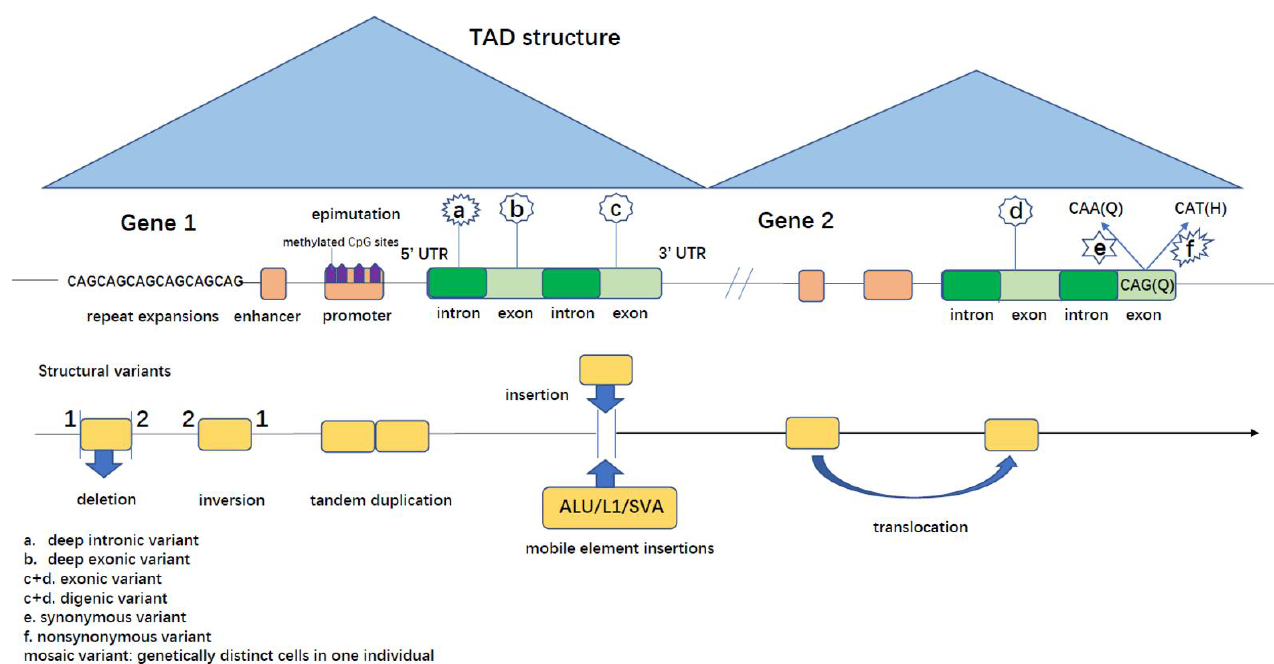
Figure 1. The schematic figure of complex genetic mechanisms.